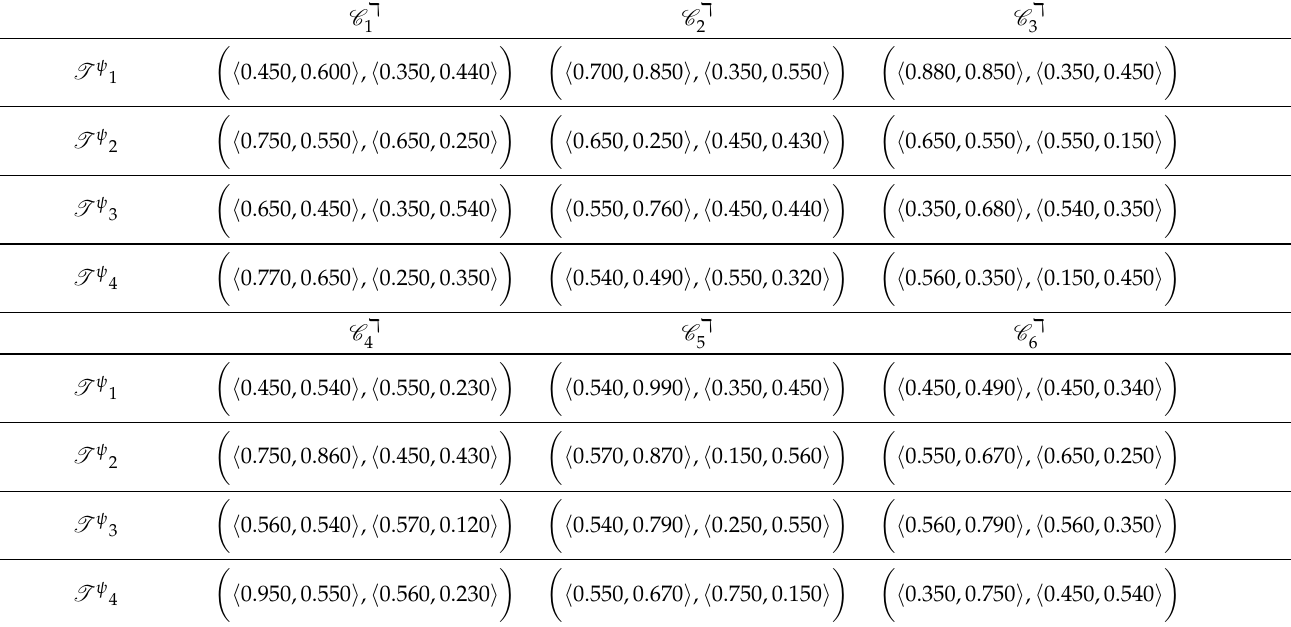
Table 6. Assessment matrix acquired from O G 2 .